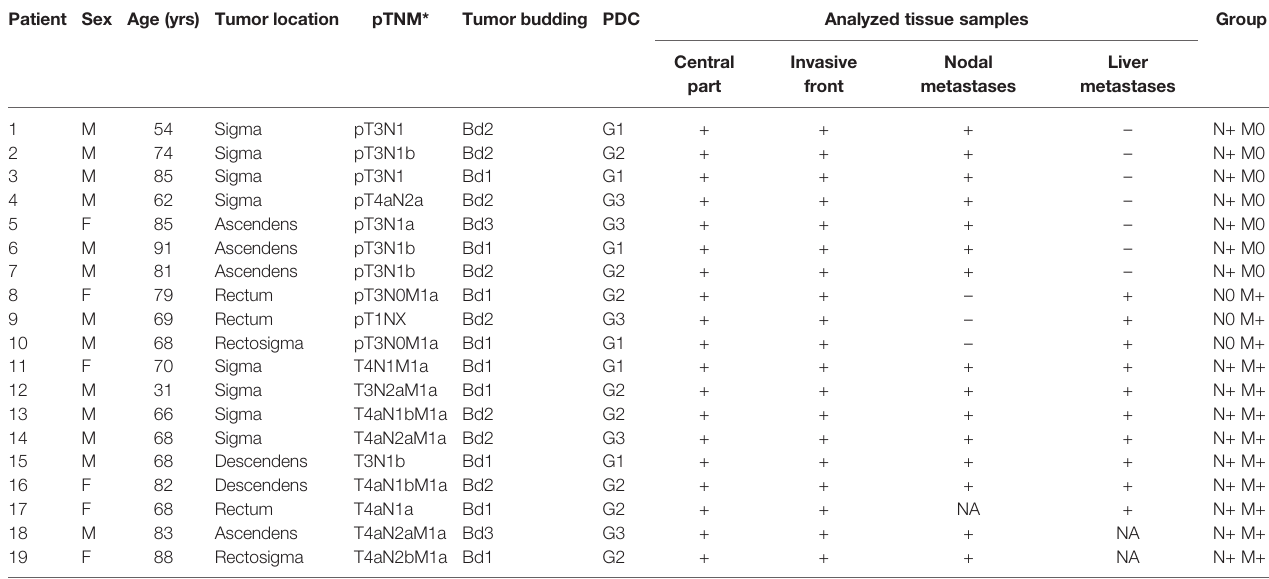
TABLE 2 | Demographic and clinicopathologic features and information about the analyzed tissue samples. Patient Sex Age (yrs) Tumor